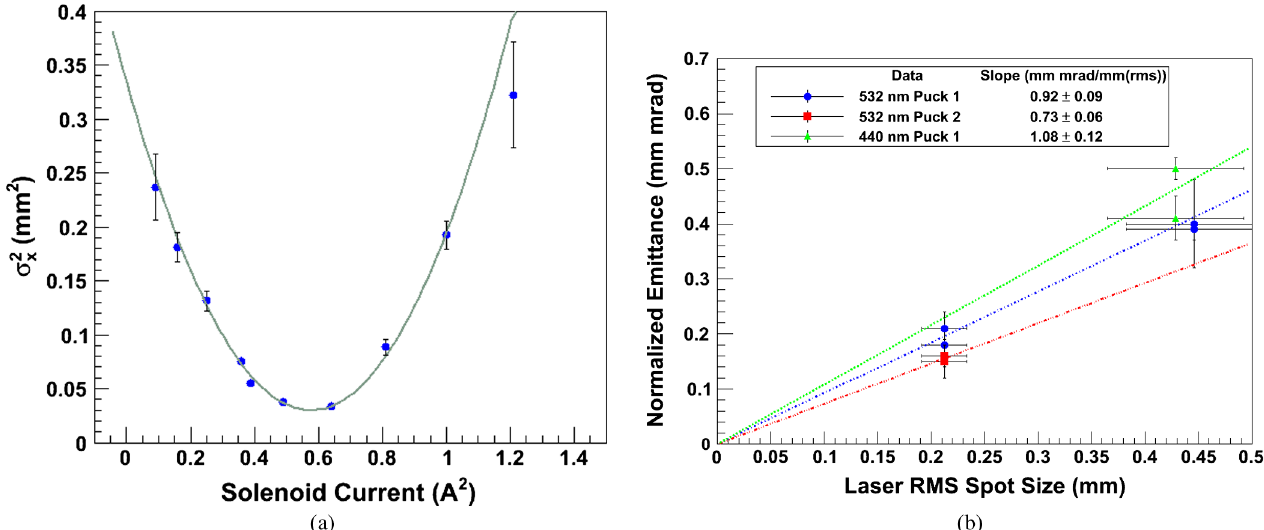
FIG. 15. (a) Gaussian beam widths in the x direction for different focusing solenoid field strengths, for beam extracted from the electrostatic center of photocathode #2. The data were fit with a parabola to determine emittance, as described in the text. (b) Normalized rms emittance measurements versus laser beam size for measurements performed on photocathodes #1 and # 2. For each photocathode-wavelength configuration, the data were fit with a line through the origin. The slope of the line yields the normalized rms emittance per laser size.